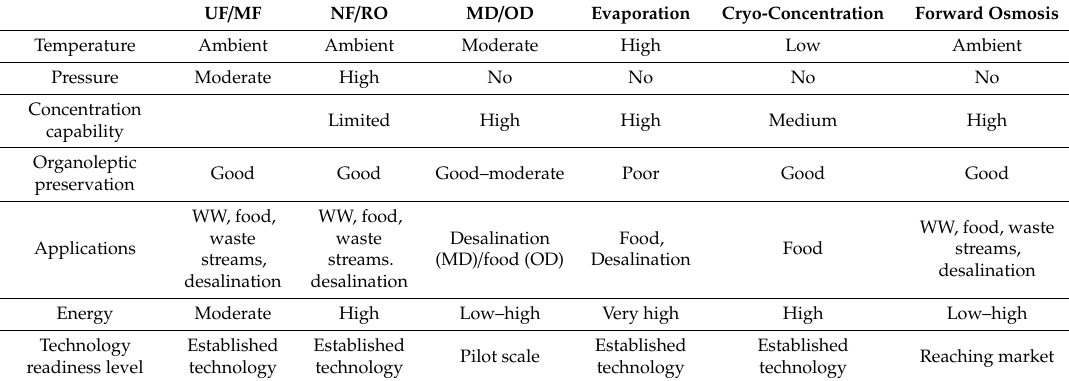
Table 1. Comparative properties and performances of concentration processes.